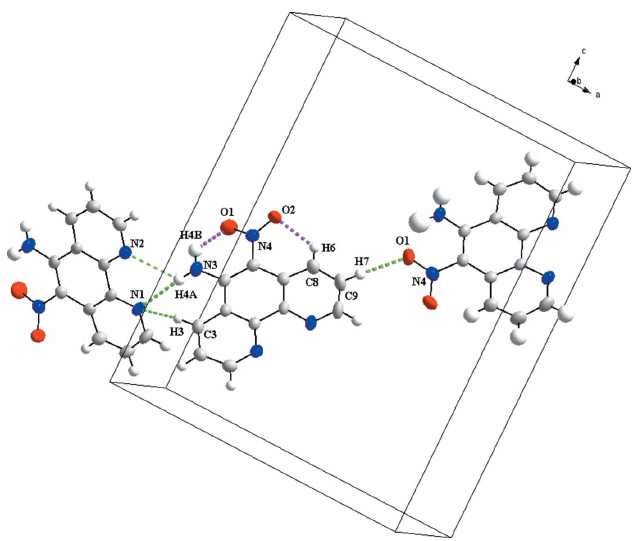
Figure 2 Illustration of the hydrogen-bonding interactions observed in 5-amino-6- nitro-1,10-phenanthroline. Intermolecular interactions are illustrated in green dashed lines while intramolecular interactions are illustrated by purple dashed lines.